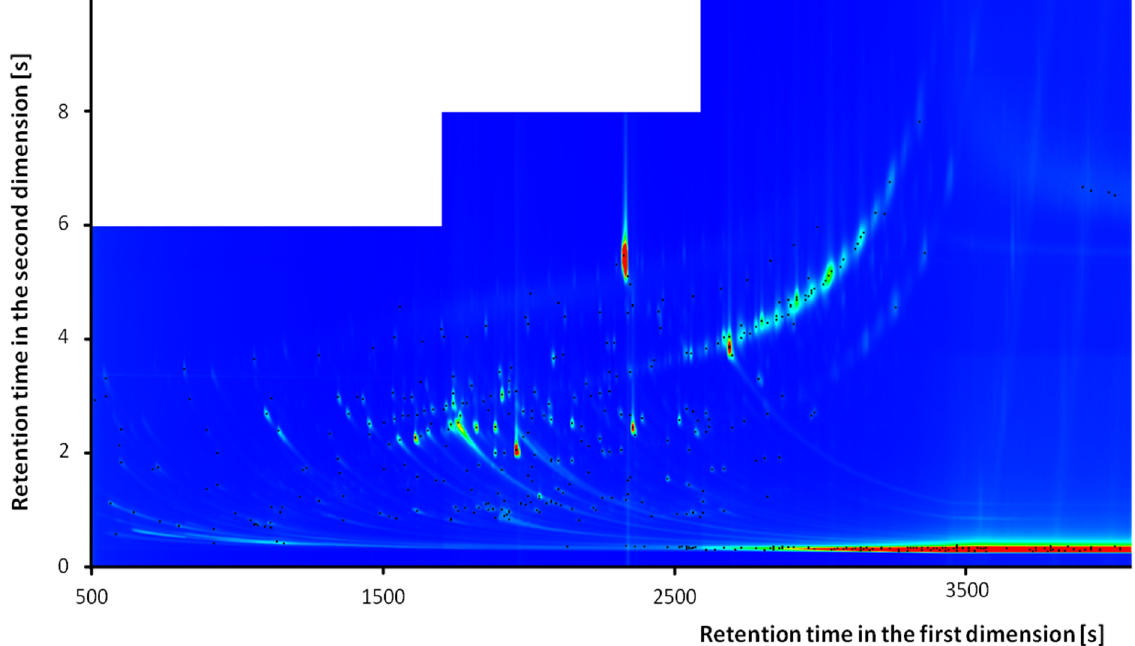
Figure 9. The TIC 2D chromatogram of a real scent sample measured under the conditions described in Section 2.4 on Rxi-200 MS (2 + 30 m) and TG-5HT (1 m) columns.